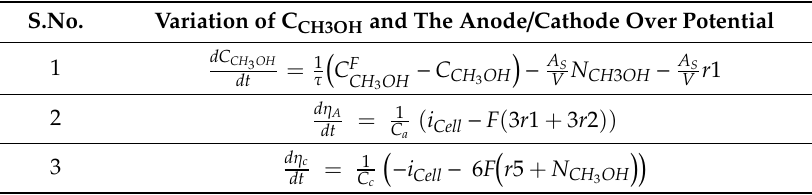
Table 1. Equation for the variation of C CH3OH and theanode / cathode overpotential. S.No.